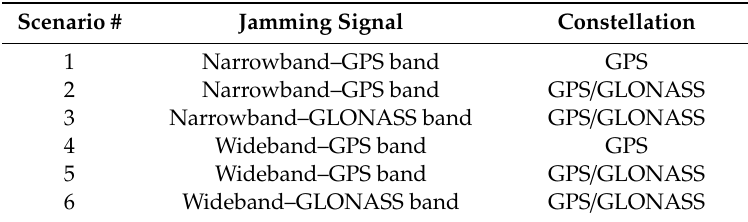
Table 2. Simulated scenarios description.